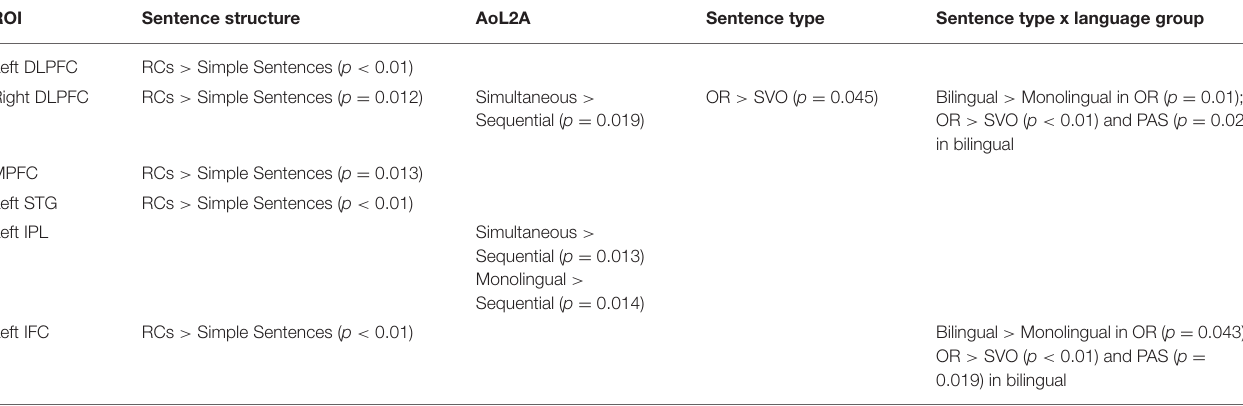
TABLE 4 | Main effects of sentence structure, AoL2A, sentence type and sentence type x language group interaction across ROIs for monolingual and bilingual children. ROI Sentence